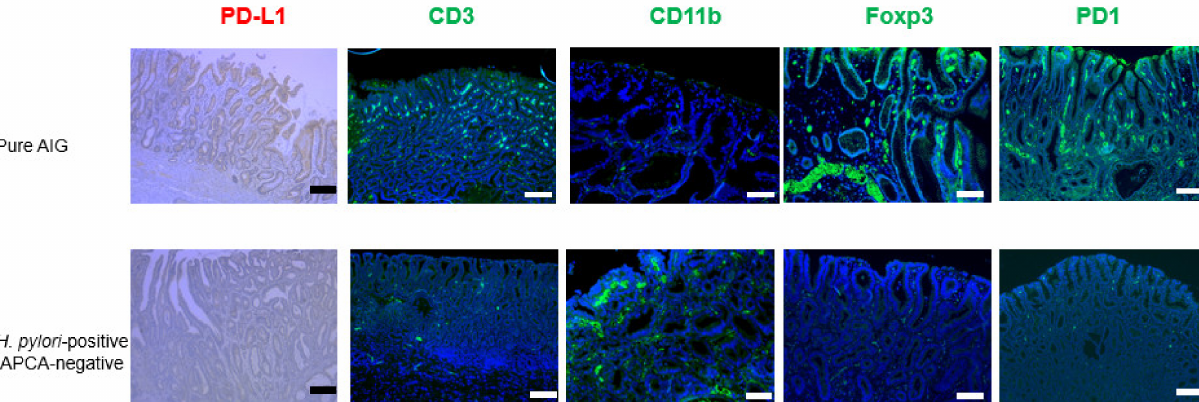
Figure 4. Immunohistochemical staining for PD-L1, CD3, CD11b, Foxp3, and PD1 in gastric cancer in pure AIG and H. pylori /APCA-negative patients. Elevated PD-L1 expression and infiltration of CD3/Foxp3/PD1-positive cells in gastric cancer is associated with pure AIG. Scale bars, 200 µ